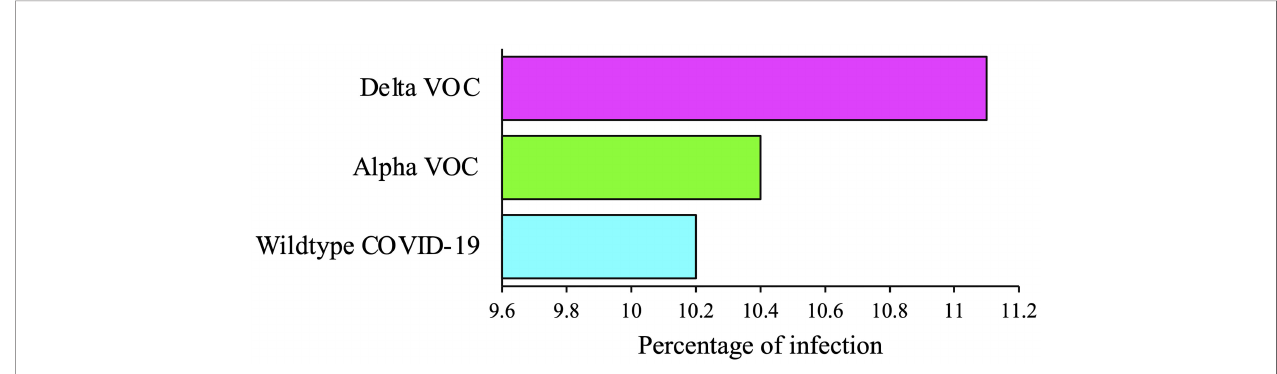
FIGURE 2 | Gestational diabetes mellitus (GDM) with COVID-19 infections during wild-type, Alpha, and Delta periods. Comparison of COVID-19 infection rates in percentage among pregnant women with GDM during wild-type, Alpha VOC, and Delta VOC periods.